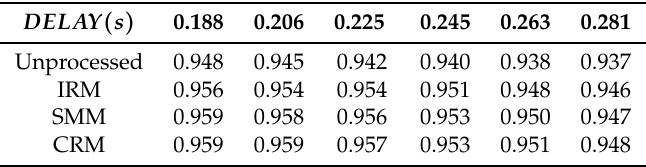
Table 3. Effect of time delay on